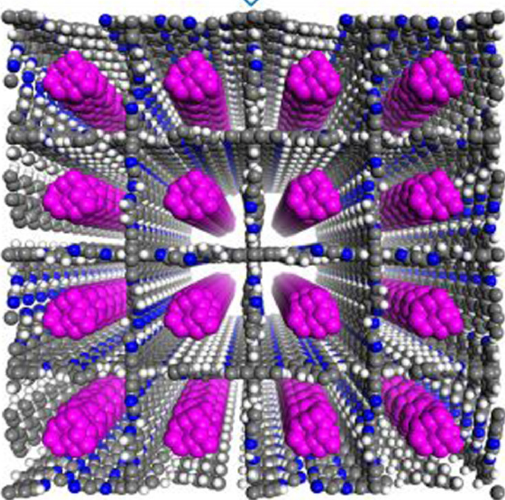
Figure 18. Schematic representation of 3D COF-SP-BPY [64].